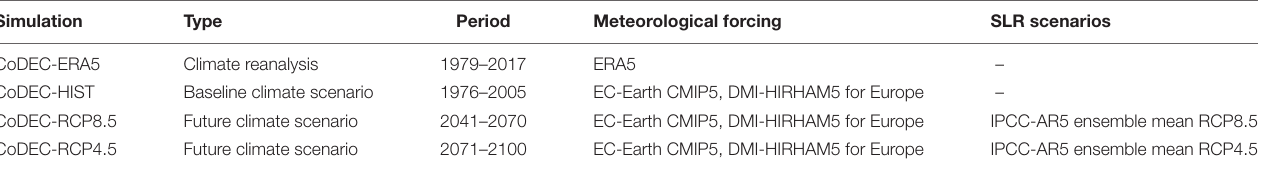
TABLE 1 | Overview of the different CoDEC simulations, including the epochs and scenarios